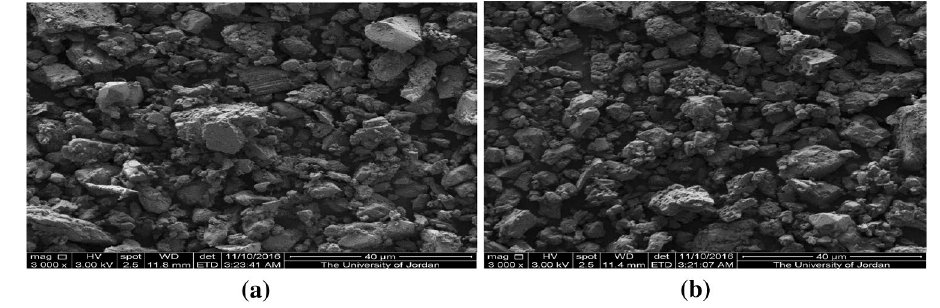
Fig. 4 Scanning electron micro- graphs a Magnesia b Magne- sia-1 LS